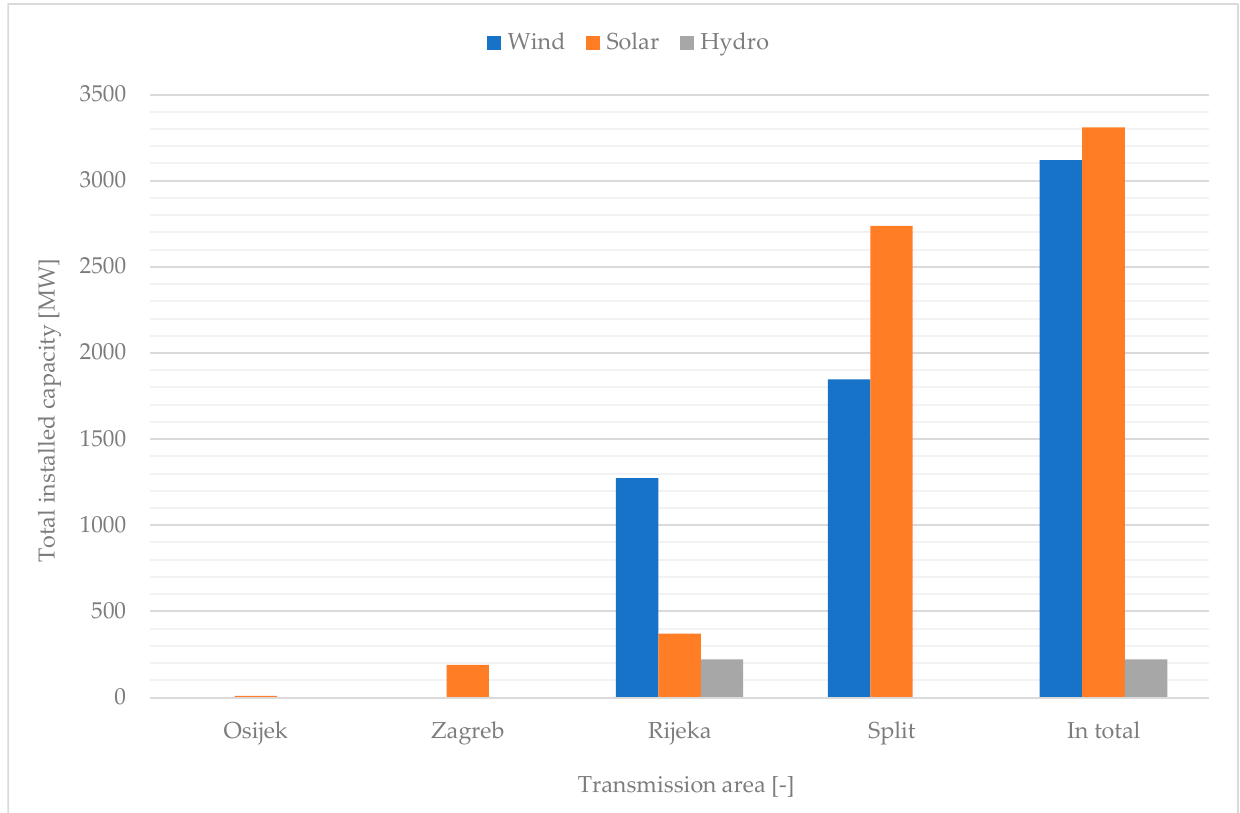
Figure 4. Total planned capacity in the period 2020–2030 divided by transmission area of the Croatian power system.